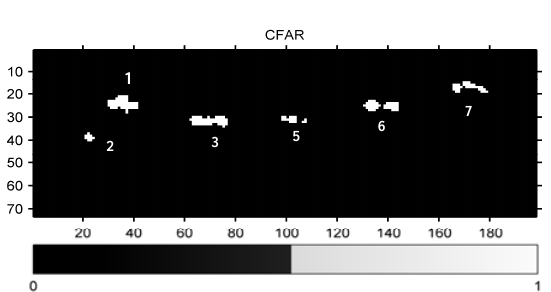
Figure10. The result of CFAR.